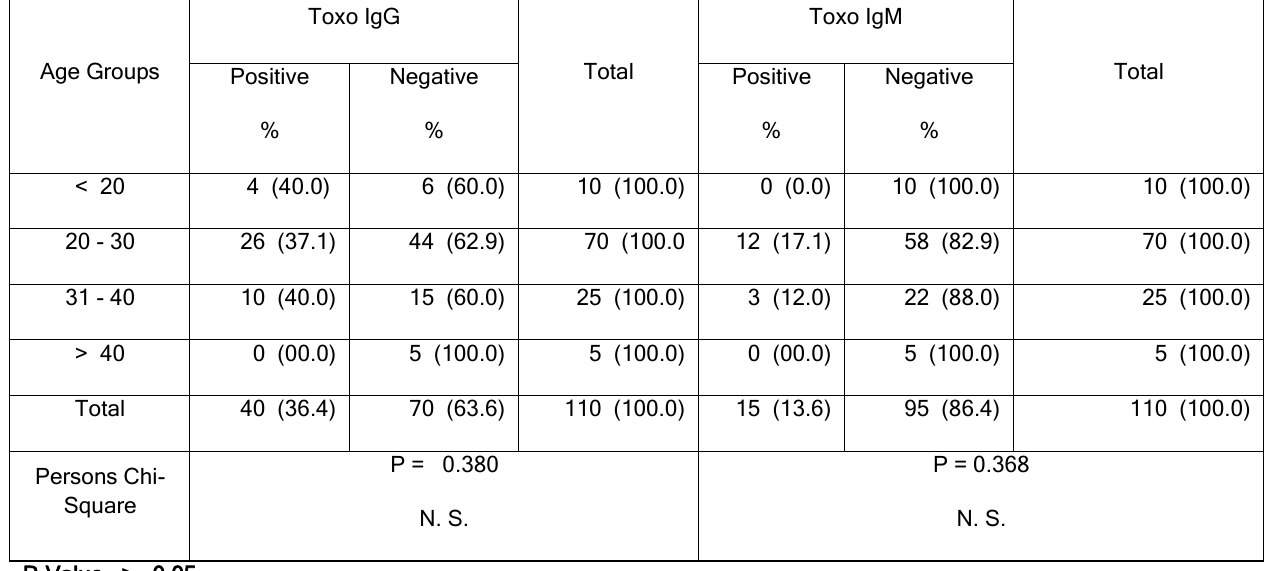
Table (2): The seropositivity rates by ELISA Toxo . IgM and Toxo. IgG according to age groups (Years).